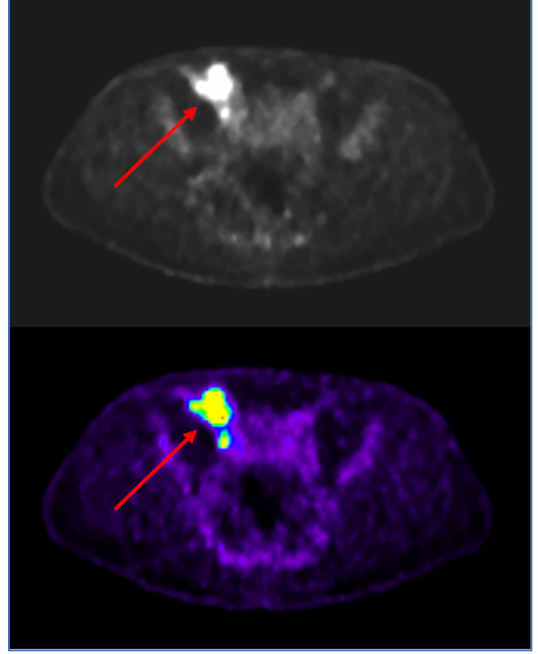
Figure 4. Fluorodeoxyglucose positron emission tomography (FDG-PET): Hypermetabolic iliac lymph node (red arrows), with high SUV-max (12.4) suggestive of inflammation or hypercellular tissue, in perfect agreement with the MR DWI image